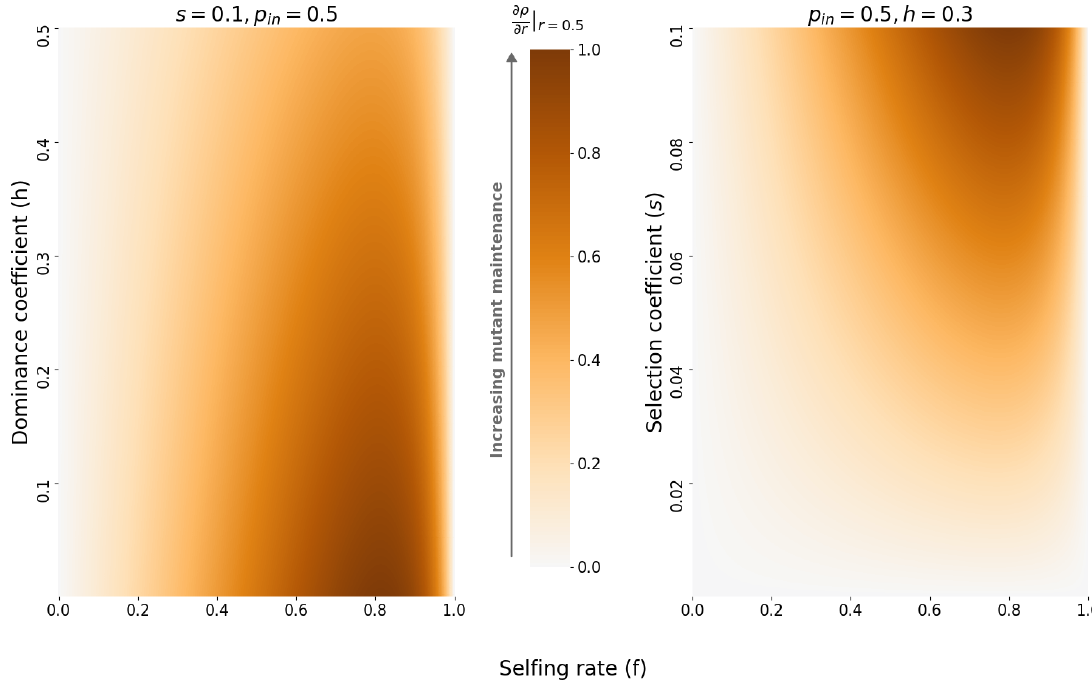
Figure S2 – Relative variation of the derivative of the eigenvalue in the partial dominance case, for varying selfing rate f (x-axis), dominance coefficient h (y-axis, left) and selection ∂ρ coefficient s (y-axis, right). For each panel, the values of ∂ r | r =0.5 range from a minimal value, which is negative, to zero. We divided each value of the derivative by this minimum in order to plot values between 0 and 1 for every panel. This enables us to compare the impact of different parameters ( h , s and f ) on the sheltering effect of the mating-type locus. The darker the color, the more the mating-type locus shelters the mutation, thus promoting its